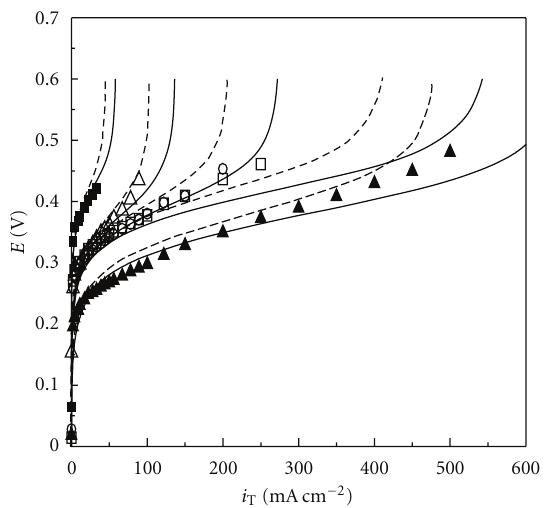
Figure 2: Comparison of calculated and experimental anode polar- isation data at various temperature and methanol concentration, κ e = 3 . 4 Ω − 1 m − 1 , D e = 3 . 04 × 10 − 10 m 2 s − 1 ; experiment data: = 1 . 0 M, T = 303 K, ( (cid:3) ) c 0 ( (cid:2) ) C 0 M = 0 . 5 M, T = 333 K, ( (cid:2) ) C 0 ( (cid:6) ) C 0 M = 2 . 0 M, T = 333 K; simulation results: solid line ( (cid:4) ) C 0 M l = 10 μ m, a = 118317 m − 1 ; dash line: l = 25 μ m, a = 37500 m − 1 .